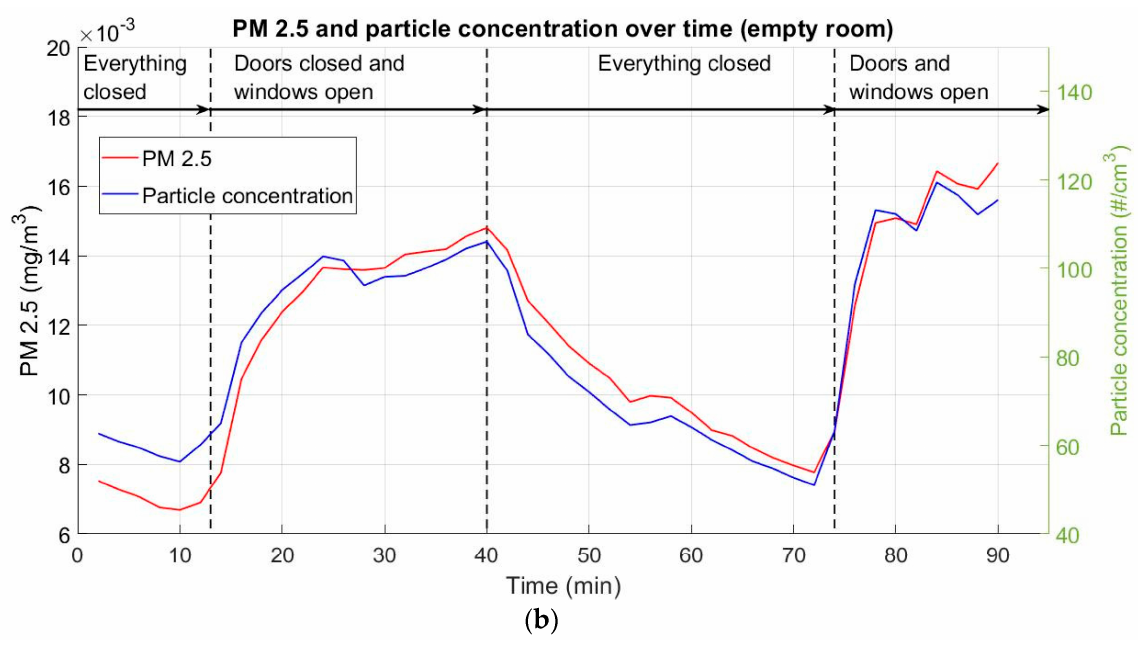
Figure 6. PM 2.5 concentration (mg/m 3 , red line) and particle concentration (amount per cm 3 , blue line). First time stretch: closed room; second time stretch: windows open; third time stretch: closed room; fourth time stretch: windows and doors open. ( a ) People in room; ( b ) empty